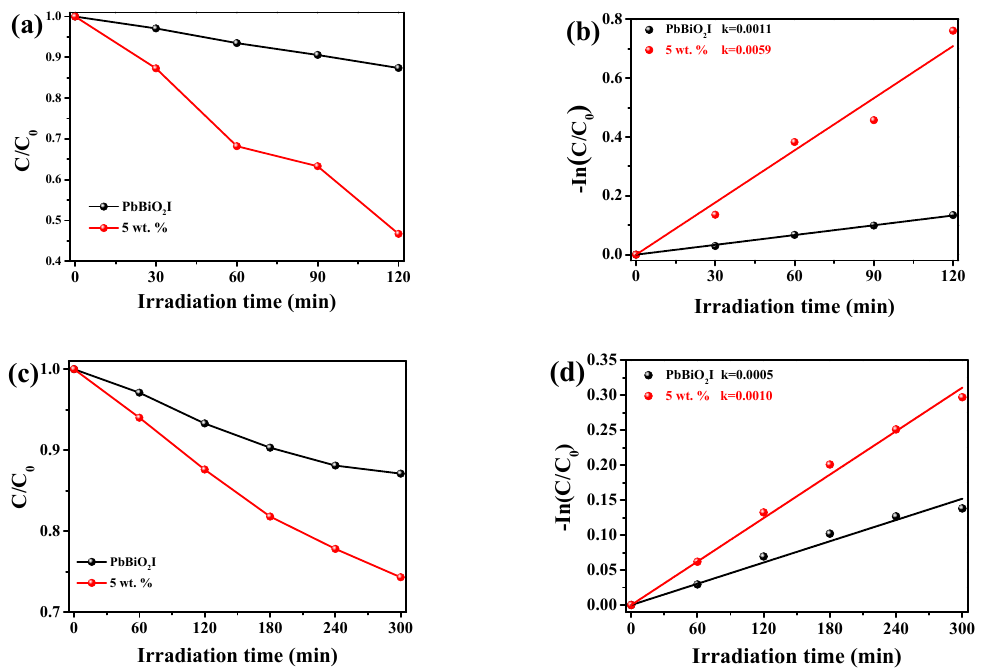
Figure 4. Photocatalytic properties of the catalysts for the degradation of RhB ( a ) and CIP ( c ) under near-infrared light irradiation ( λ > 610 nm); reaction kinetics for the degradation of RhB ( b ) and CIP ( d ) under the same condition.